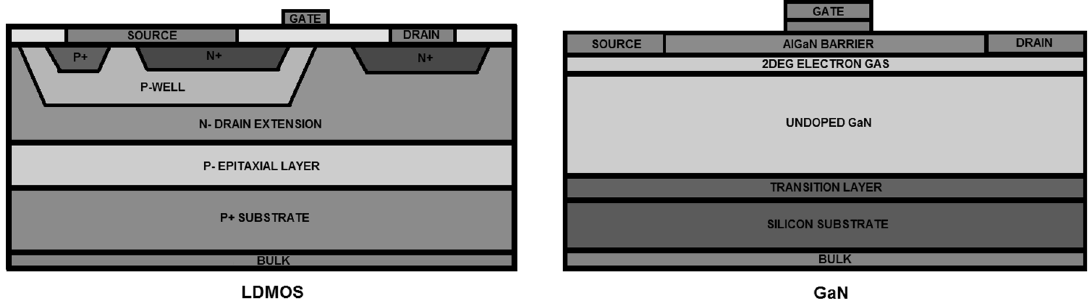
Figure 4. LDMOS and gallium nitride (GaN) transistor structures.